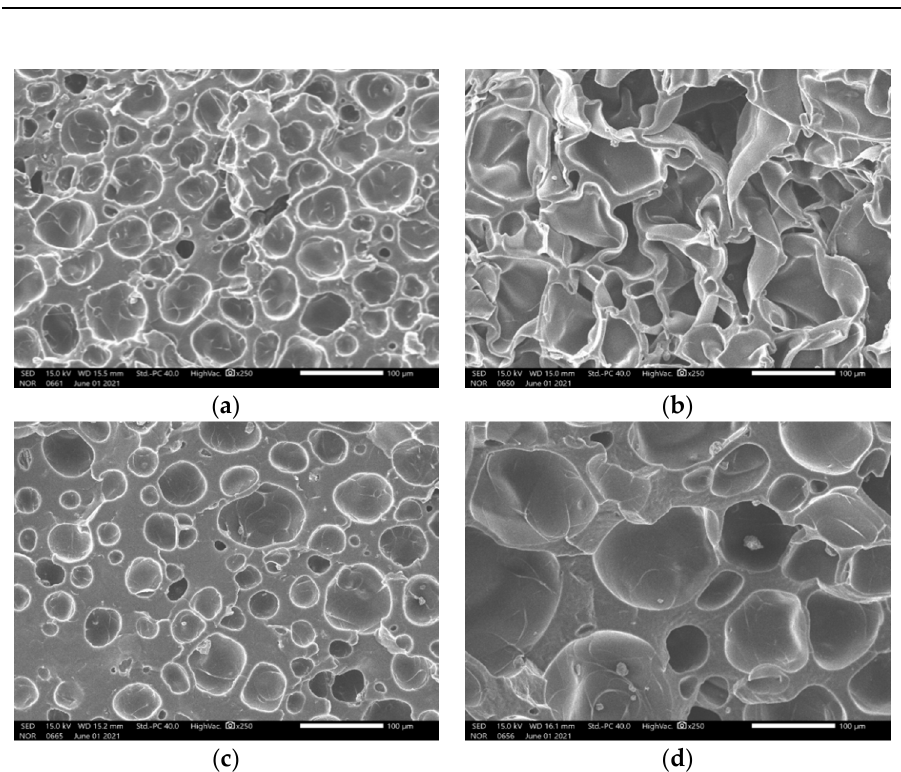
Figure 6. Scanning electron micrograph of ceramic urethane specimens for high-frequency measurements: ( a ) Microcellular foamed at 150 °C and 30 s (at a magnification of ×250); ( b ) Microcellular foamed at 150 °C and 90 s (at a magnification of ×250); ( c ) Microcellular foamed at 170 °C and 30 s (at a magnification of ×250); ( d ) Microcellular foamed at 170 °C and 90 s (at a magnification of ×250).